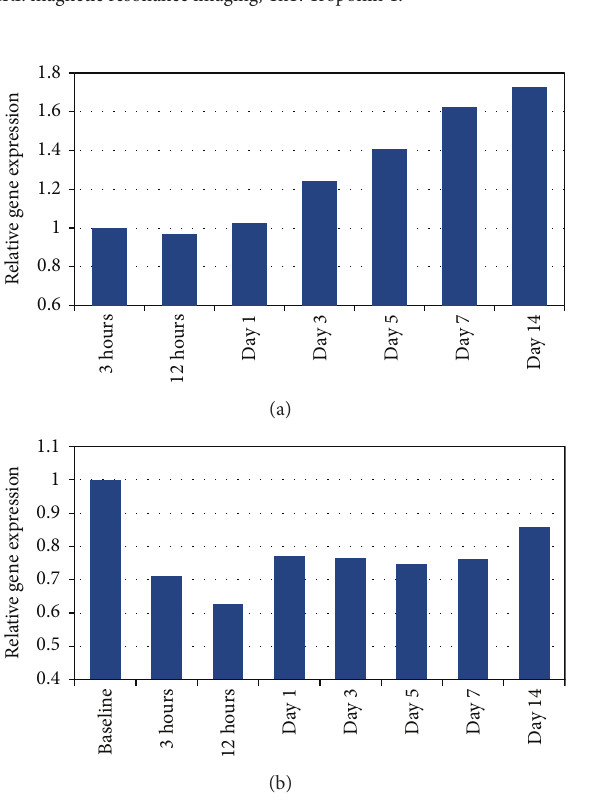
Figure 2: (a) Gene expression of PTX3 in circulating leukocytes relative to 3 hours’ levels in the AMI group. (b) Gene expression of PTX3 in circulating leukocytes relative to baseline levels in the AP